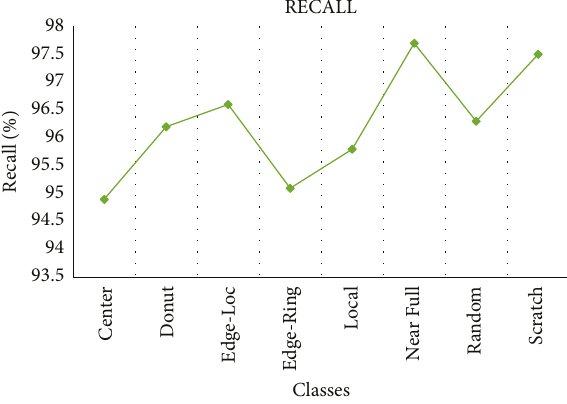
Figure 9: Graphical plot of ShuffleNet-v2-CNN’s recall performance.